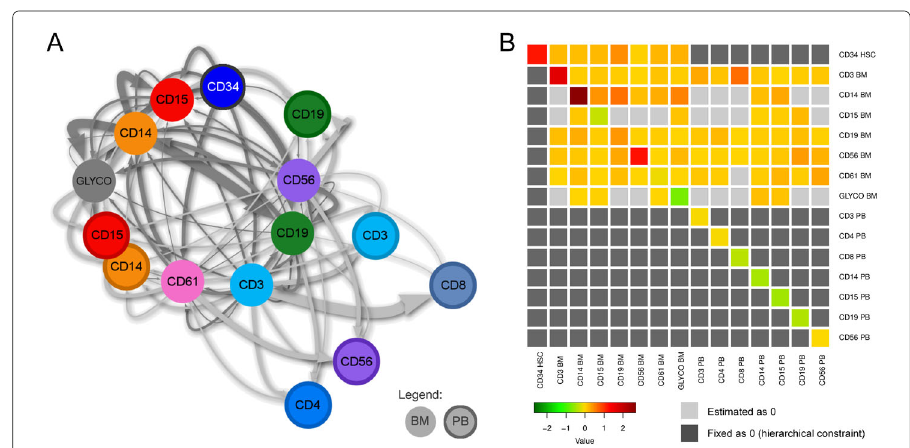
Fig. 6 Estimated human hematopoietic differentiation process. a The network configuration of the human hematopoietic differentiation process. Nodes representing lineages positive for the surface marker and collected from bone marrow and peripheral blood (circled) have the same color. Lymphoid lineages have a blue/green color, whereas myeloid cell types are red/orange and violet. The node corresponding to the stem cell (CD34) is dark blue and circled in black. Glycophorin positive cells(Glyco) and CD61 are respectively grey and pink. Network layout has been generated with a force directed layout. b Parameters heatmap. Main diagonal elements correspond to netduplicationrate . Off-diagonal elements correspond to differentiation rates (row → column). Light-Grey entries are differentiations rates estimated as 0 by SCAD penalization (23). Dark-Grey entries are excluded from the inferential procedure due to violation of hierarchical constraints